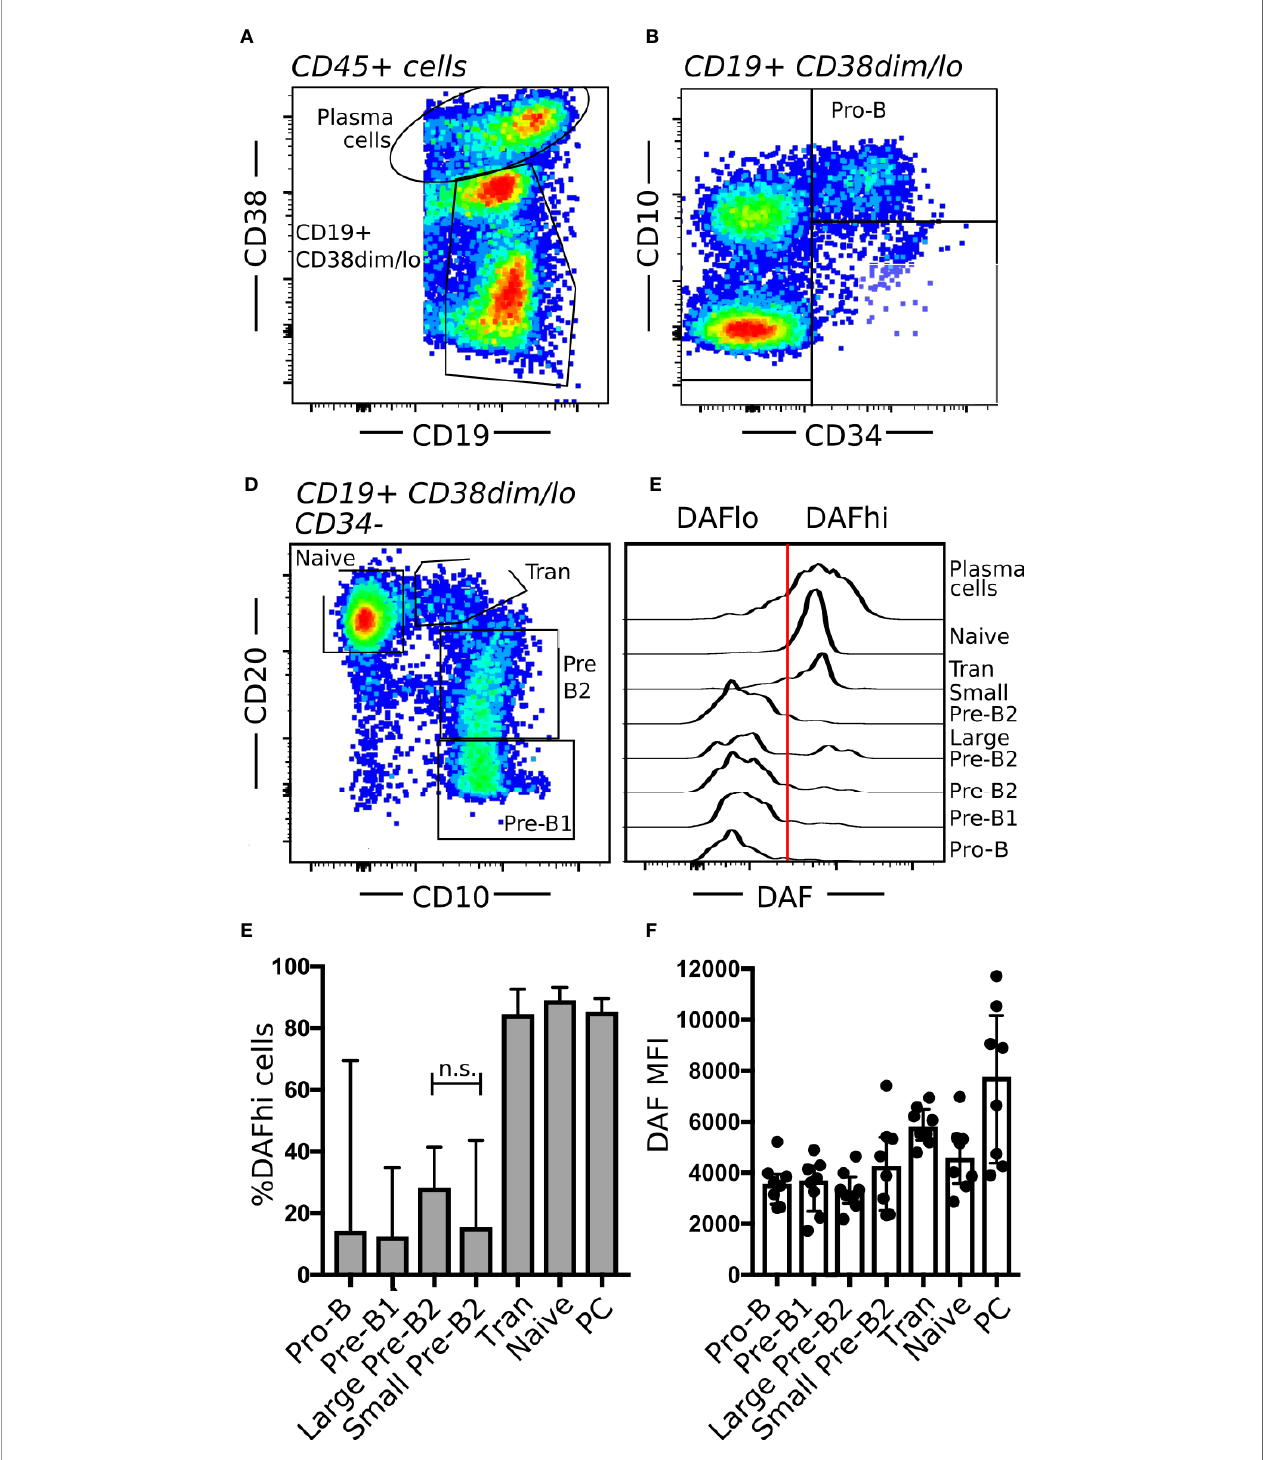
FIGURE 6 | Regulation of DAF expression during B cell hematopoiesis. (A – C) Flow cytometric analysis of human bone marrow aspirates. Shown are (A) PCs (CD19 + CD38 hi ) and B cells (CD19 + CD38 dim/lo ), (B) Pro-B cells (CD34 + CD10 + ), and (C) Pre-B1 cells (CD10 + CD20 − ), pre-B2 cells (CD10 + CD20 + ), transitional B cells (Tran, CD10 dim CD20 ++ ), and mature B cells (CD10 − CD20 ++ ). (D) Representative histogram of DAF expression from respective B cell subset in bone marrow. The line indicates the cutoff for determination of high or low DAF expression. (E, F) Quanti fi cation of data from (D) . Shown is median with interquartile range. n.s., non-signi fi cant. N =